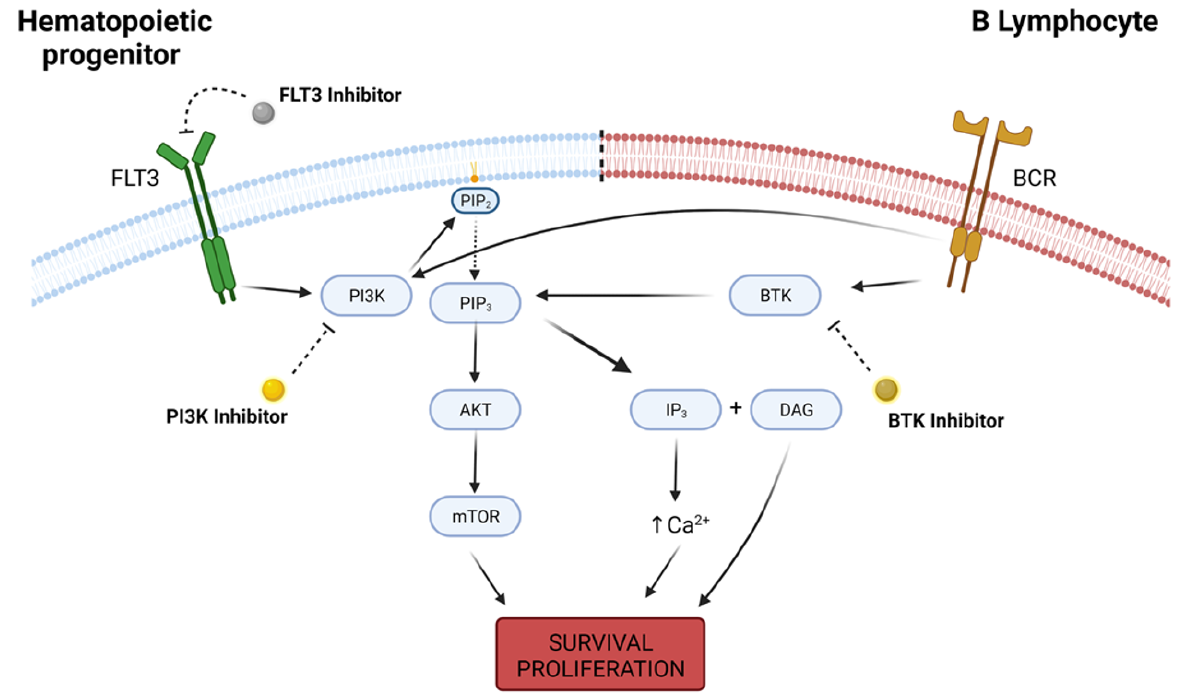
Figure 3. Intracellular pathways of FLT3, PI3K and BTK. FLT3 is a receptor tyrosine kinase highly expressed in hematopoietic progenitor cells, and its activity leads to downstream activation of survival pathways such as PI3K, which in turn converts phosphatidylinositol 4,5-bisphosphate (PIP2) into phosphatidylinositol-3,4,5-trisphosphate (PIP3) and recruits AKT to the cell membrane, with further upregulation in mTOR activity. PI3K/AKT/mTOR pathway is responsible for a wide variety of physiological functions that determine cellular survival and proliferation. On B lymphocites, B-cell receptor (BCR) is a transmembrane immunoglobulin that, upon activation, signals for PI3K and BTK activity. BTK regulates PIP3 degradation into IP3 (inositol 1-4-5 trisphosphate) and DAG (diacylglycerol), increasing intracellular calcium concentration and also promoting cellular survival and proliferation. Deregulation in the expression of any of these kinases may lead to malignant cell phenotype, and kinase inhibitors are a possible therapeutic option in the oncological practice. Created with BioRender.com, accessed date: 20 August 2021.